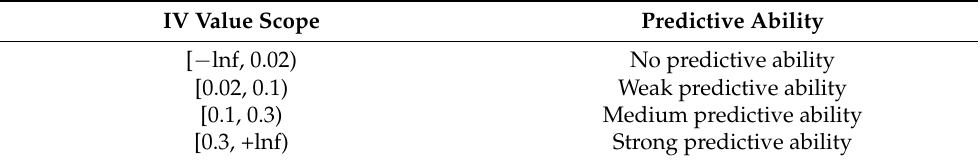
Table 4. Measurement of IV